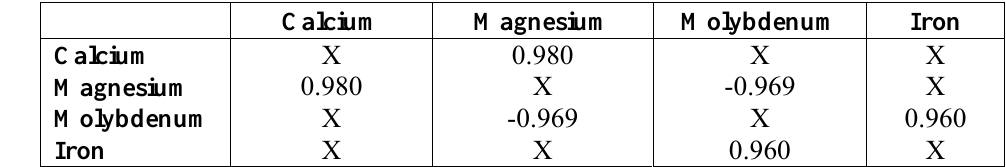
Table 3. Mutual correlation of four elements found in medlar fruit extracts. The values of correlation coefficients are of P <